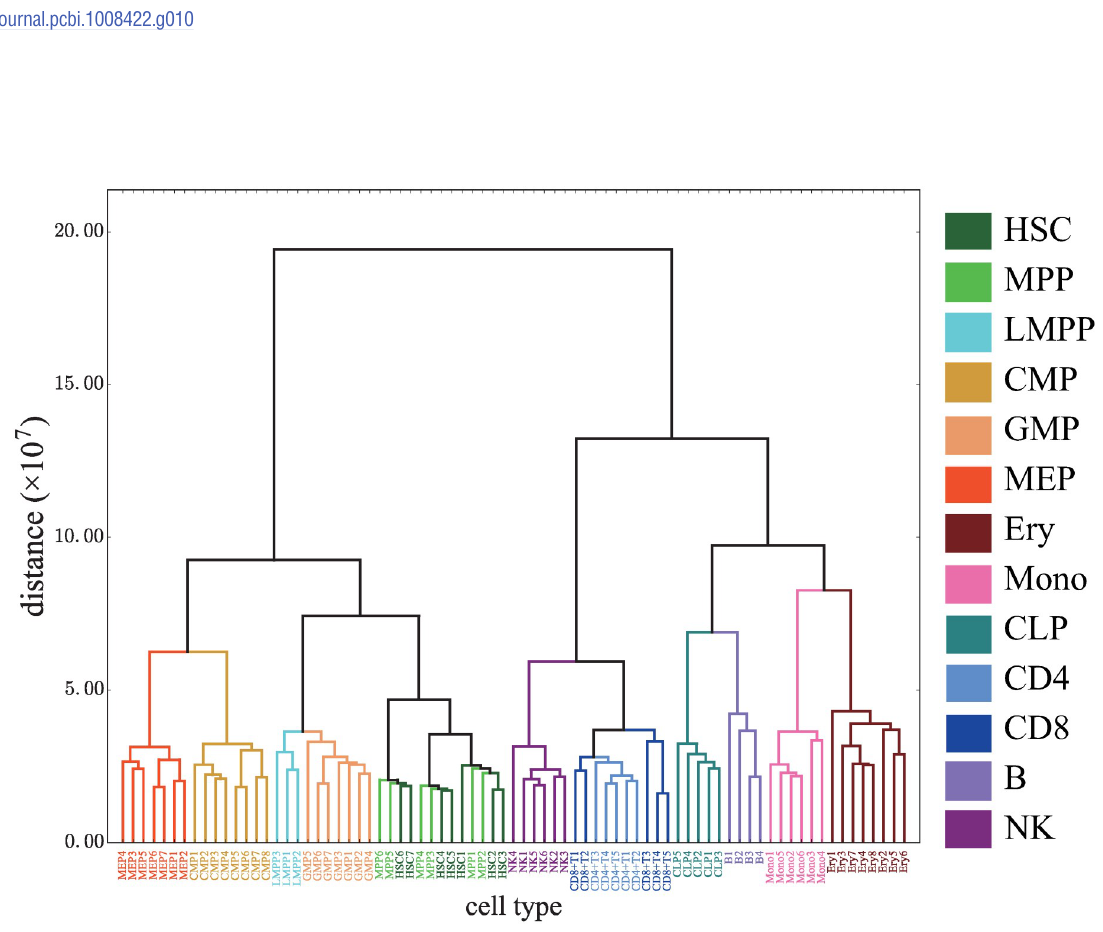
Fig 11. Our best clustering dendrogram. Hierarchical clustering obtained by Ward’s method with ( M cut , p G ) = (64000, 10 − 2 ).